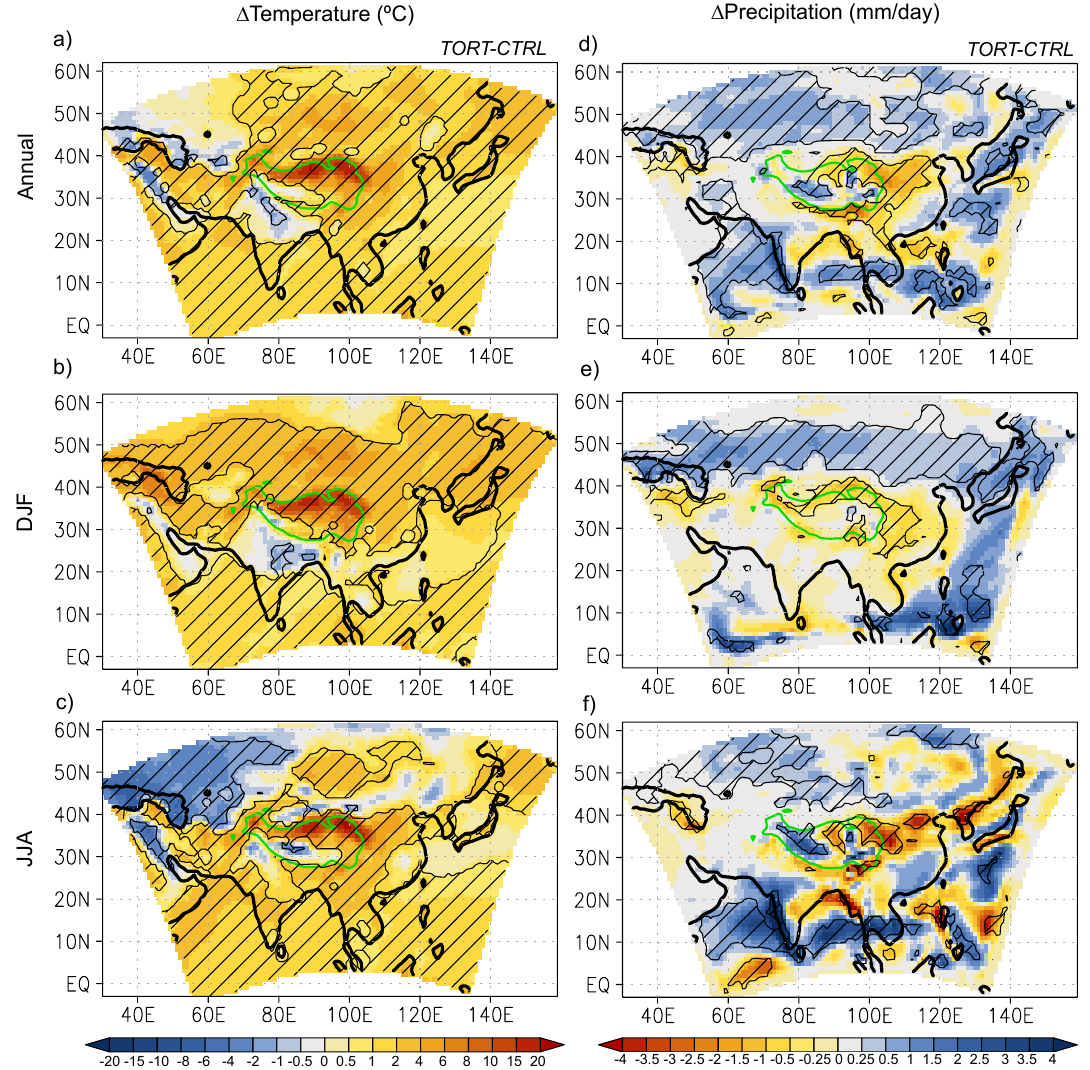
Fig. 4. Temperature ( ◦ C) and precipitation (mmday − 1 ) difference between TORT and CTRL. (a, d) Annual, (b, e) winter (DJF), (c, f) summer (JJA). The hatched areas show the significant anomalies with a Student’s t-test ( p = 0 . 05). The green contour denotes the extent of the present-day Tibetan Plateau ( > 3000m). Note that the sponge layer (the outermost 8 grid cells) of the regional model domain is kept in the